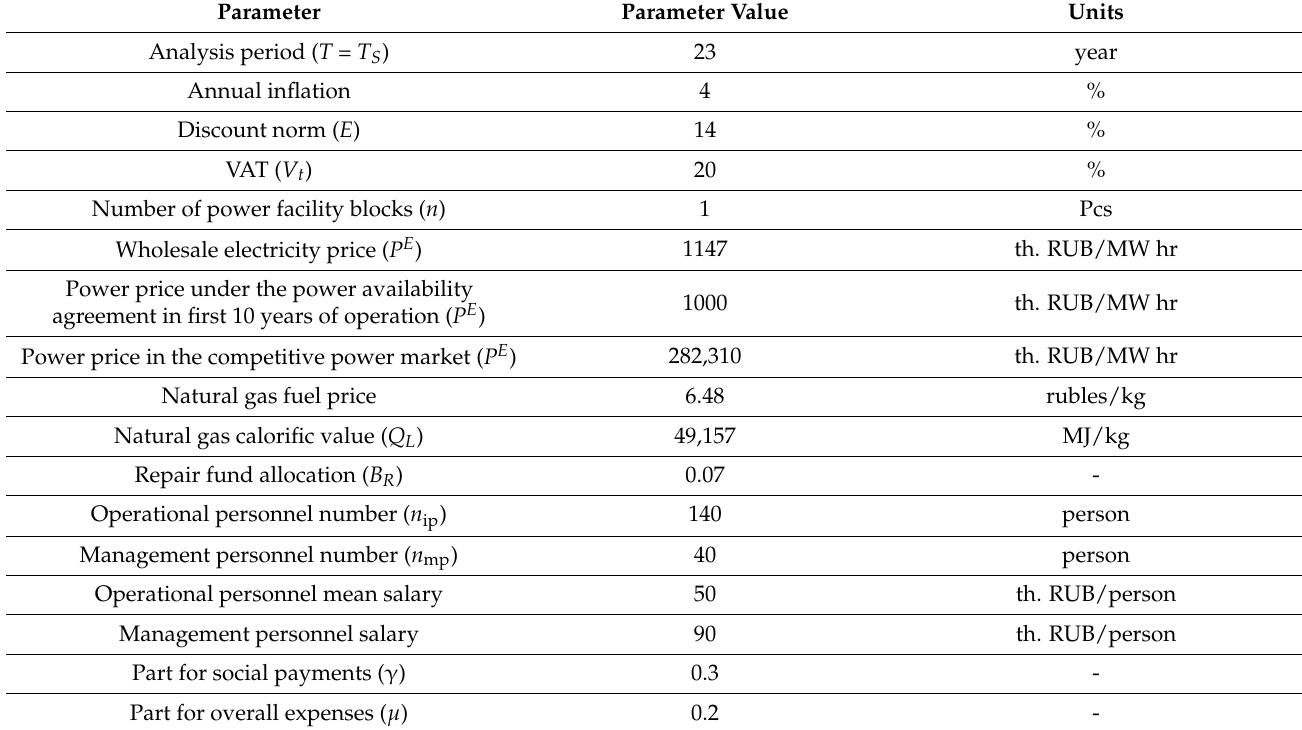
Table 6. Analysis input data for the financial efficiency of oxy-fuel